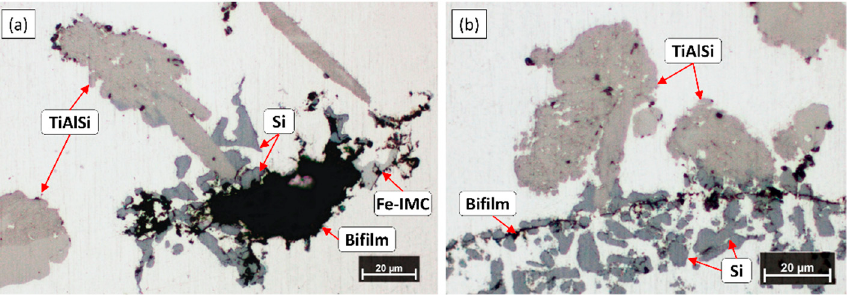
Figure 14. ( a , b ) Optical micrographs of bifilms found in the sedimented particle-rich regions formed during the A2 experiment.